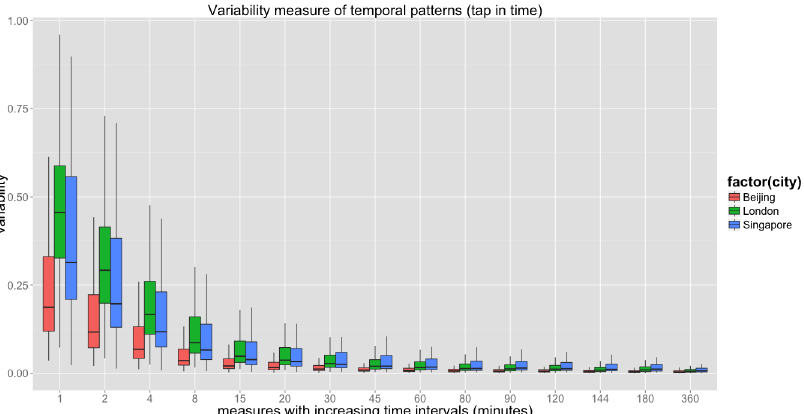
Fig 6. Comparative analysis of variability in temporal